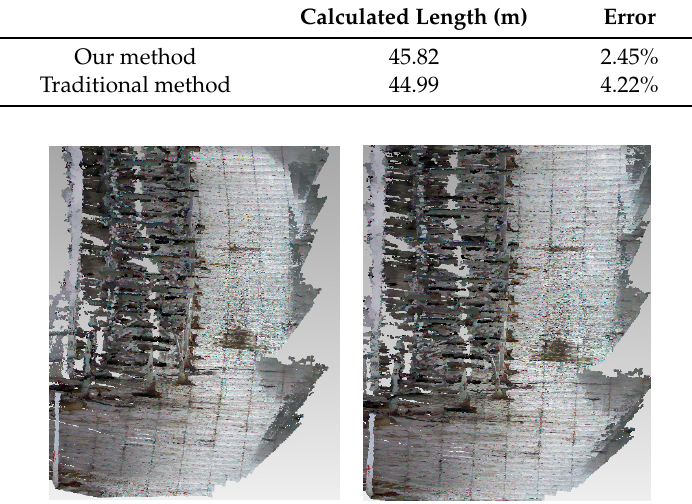
Figure 7. Overhead views of the 3D mapping results in Experiment I. The left figure is the result of the traditional method. The right is the result of the proposed method in this paper.